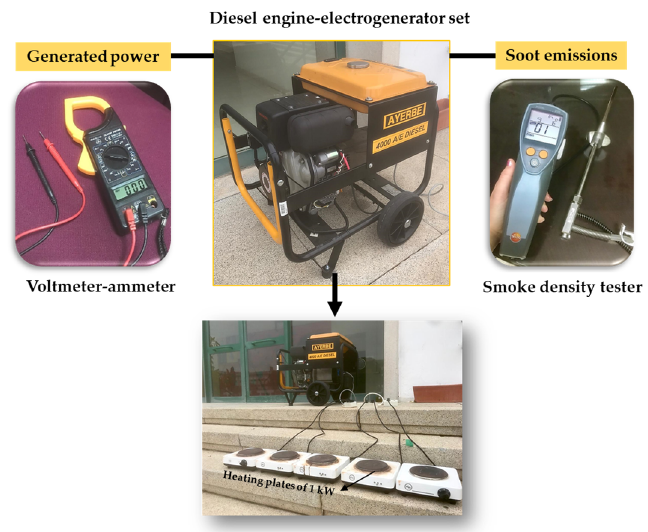
Figure 5. Schematic summary of mechanical and environmental characterization of diesel engine-electrogenerator set.